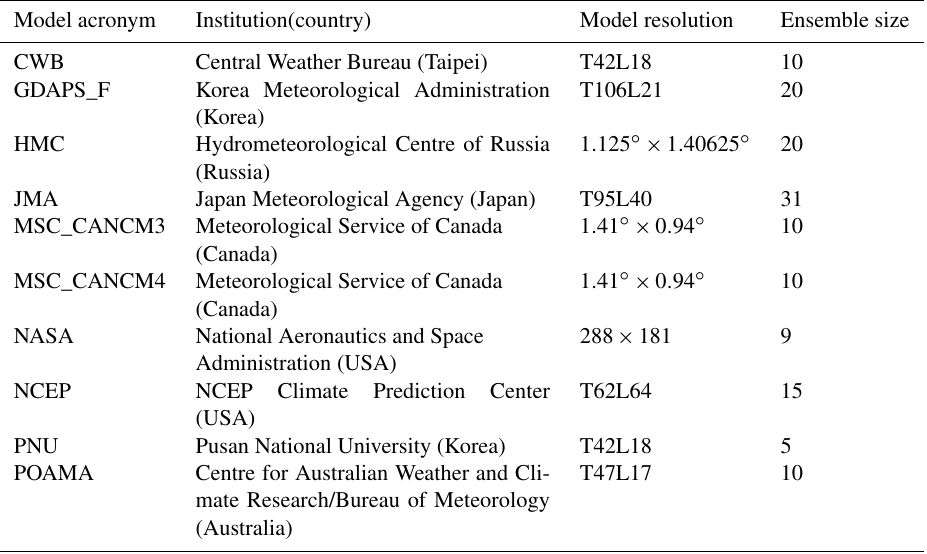
Table 1. Description of ten GCMs used as